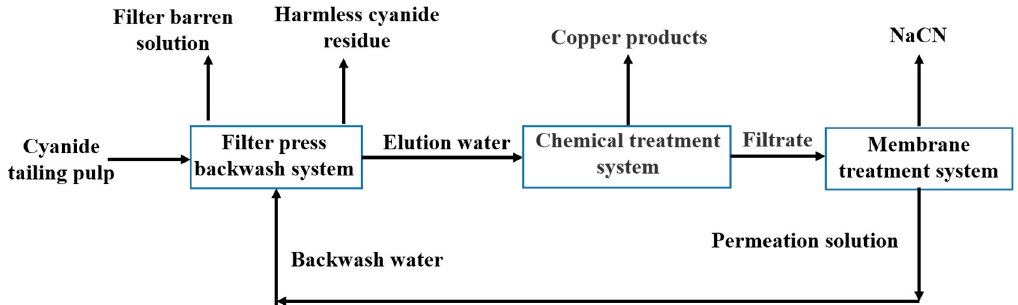
Figure 1. The process of the “filter press backwash–chemical precipitation–gaseous membrane absorption” method.